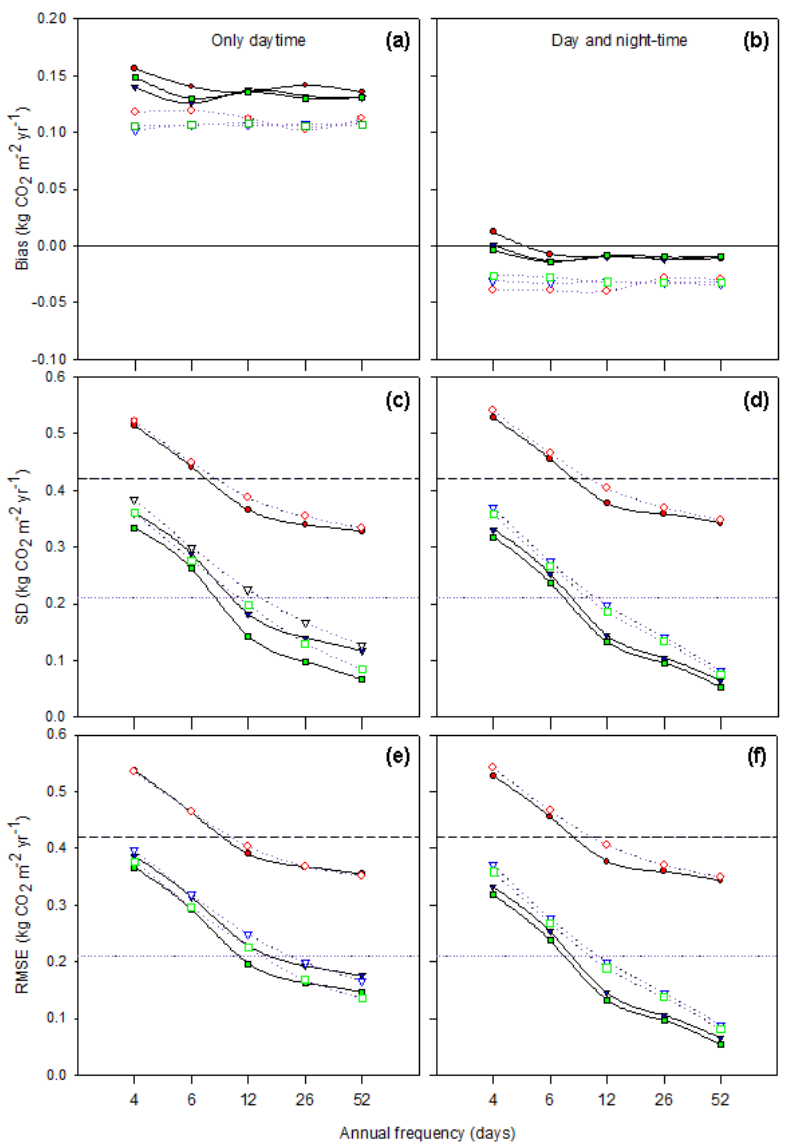
Figure 6. Bias (a, b) , SD (c, d) and RMSE (e, f) of partial-data series, related to both daily and annual frequencies of sampling, considering only daytime measurements (left), or day–night measurements (right). Symbols represent the daily frequency of sampling: red circle, 1; blue triangle, 2; green square, 4. Frequency of six measurements per day was not included to make the graph clearer, because the error values did not differ much from the ones for four measurements per day. The approach to estimate the annual flux are differentiated as follows: blank symbol and pointed line are linear interpolations; solid symbol and solid line are non-linear modelling. The reference lines in (c, d, e, f) represent 10% (dashed) and 5% (dotted) of the annual R s flux (4.15kgCO 2 m − 2 year − 1 ) .